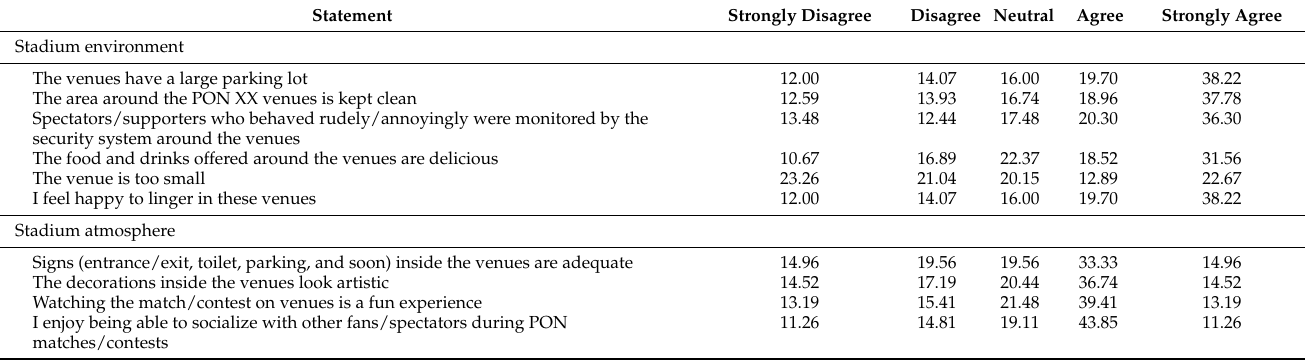
Table 4. Detailed responses of stadium environment and stadium atmosphere constructs.